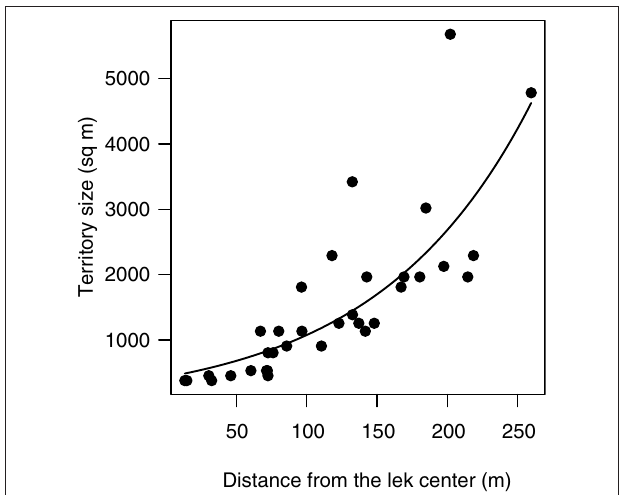
FIGURE 2 | Spatial patterns in territory size at the main lek in Velavadar during the peak in mating activity (28 February − 14 March). Territories were smallest in the lek-center and increased toward the periphery. The curve is the prediction from the GLS model (see methods). Each data point is a territory.